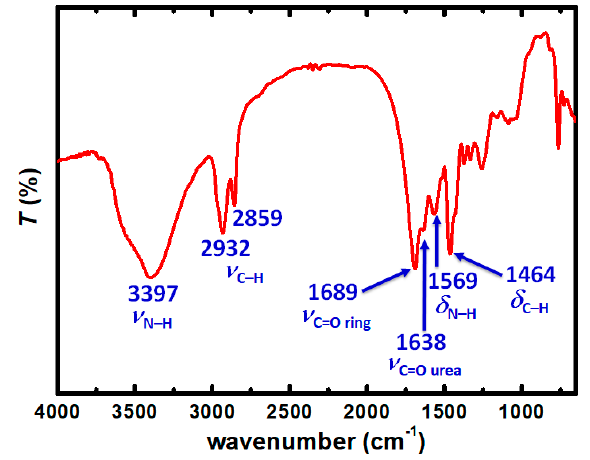
Figure 5. FT-IR spectrum of spherical PUA aerogel beads.